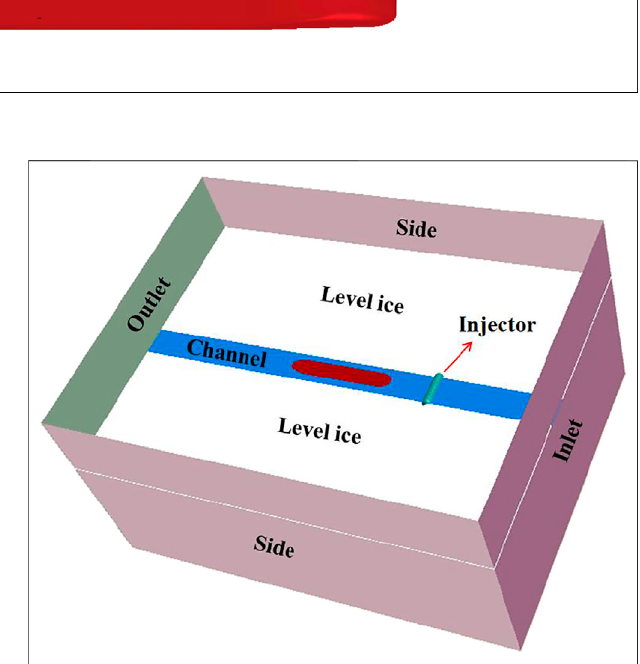
FIGURE 3 | Computational domain setting of the brash ice